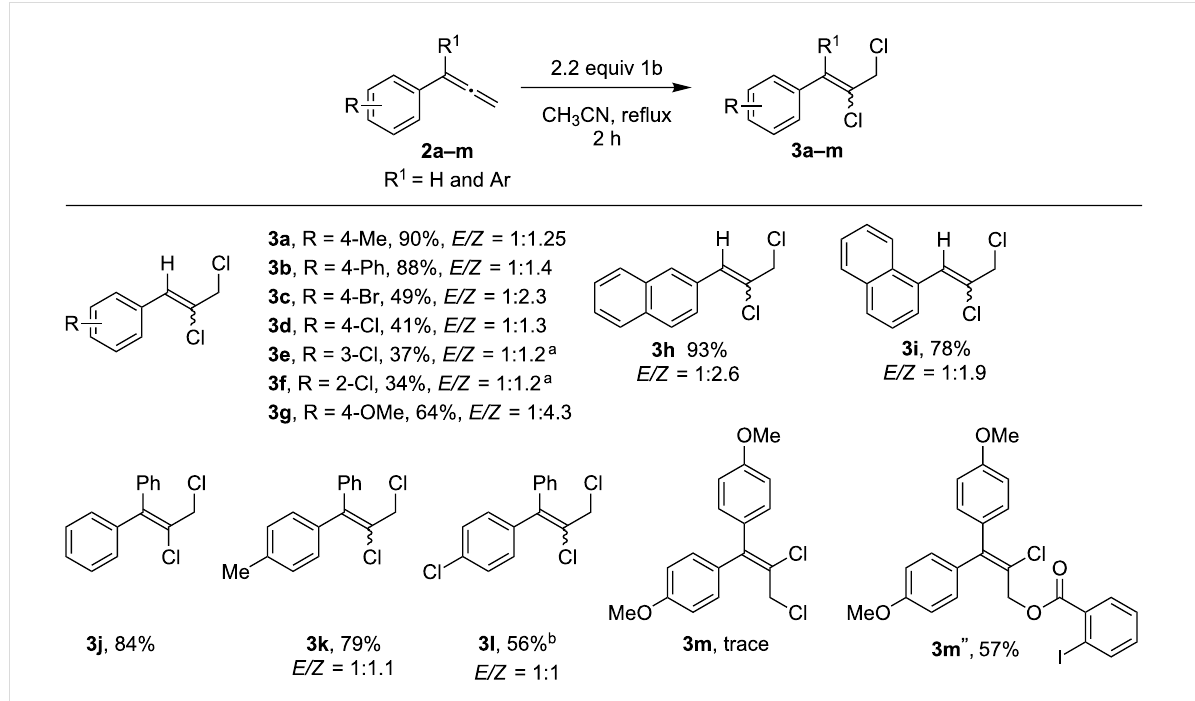
Scheme 3: Chlorination of various aryl-substituted allenes. General conditions: Allene 2a (0.2 mmol, 1 equiv) was added dropwise over 1 h to a solu- tion of 1b (0.44 mmol, 2.2 equiv) in 0.1 M CH 3 CN under reflux conditions, and the reaction stirred for 1 h; isolated yields. a 1 H NMR yield using HMDSO as internal standard.